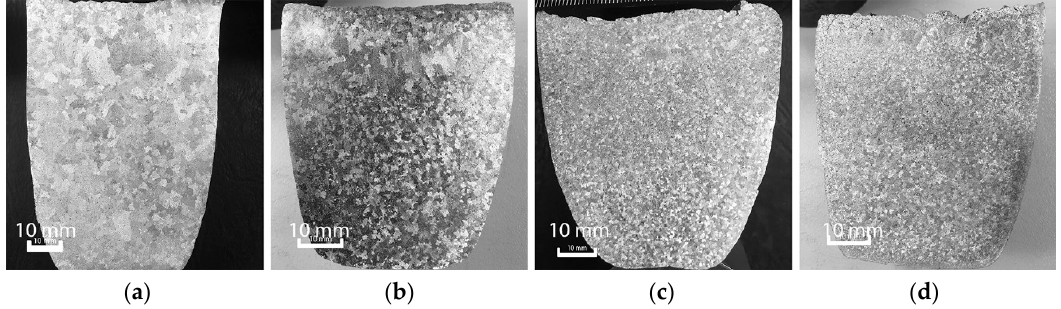
Figure 2. Macrostructures of ( a ) Al–5Mg; ( b ) Al–10Mg; ( c ) Al–15Mg; ( d ) Al–20Mg without the application of UST.